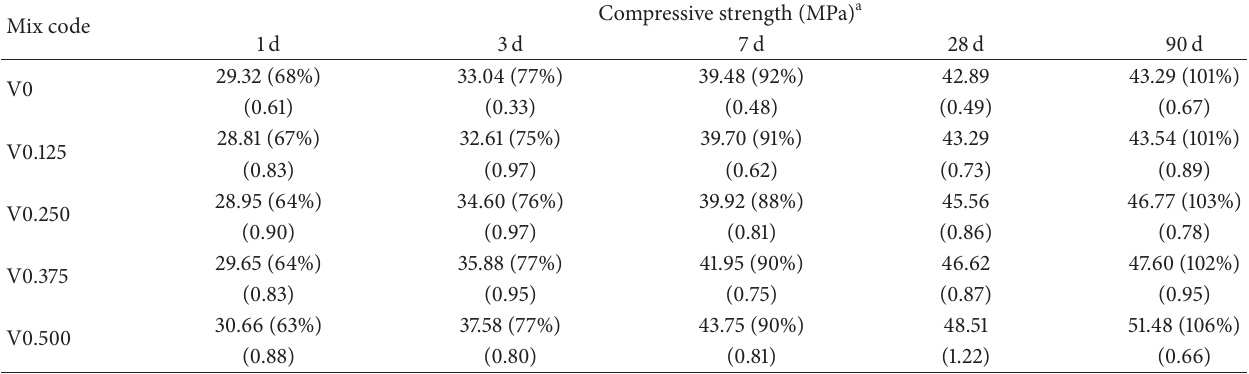
Table 5: Development of compressive strength of lightweight OPS FRC under continuous moist curing.